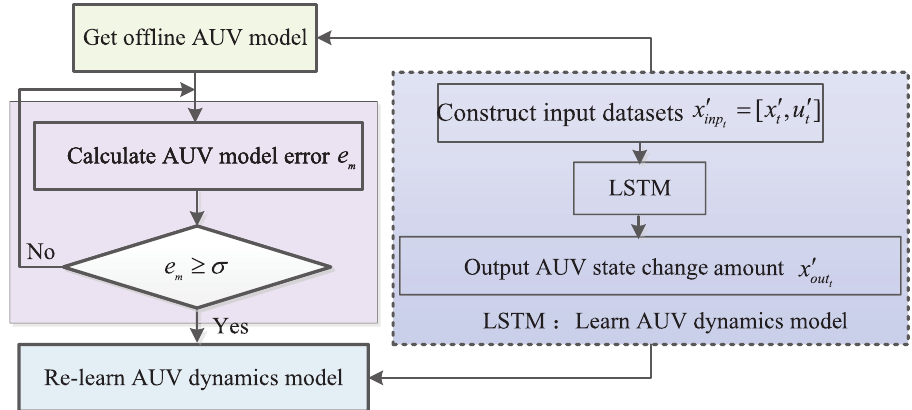
Figure 6. Block diagram of AUV model